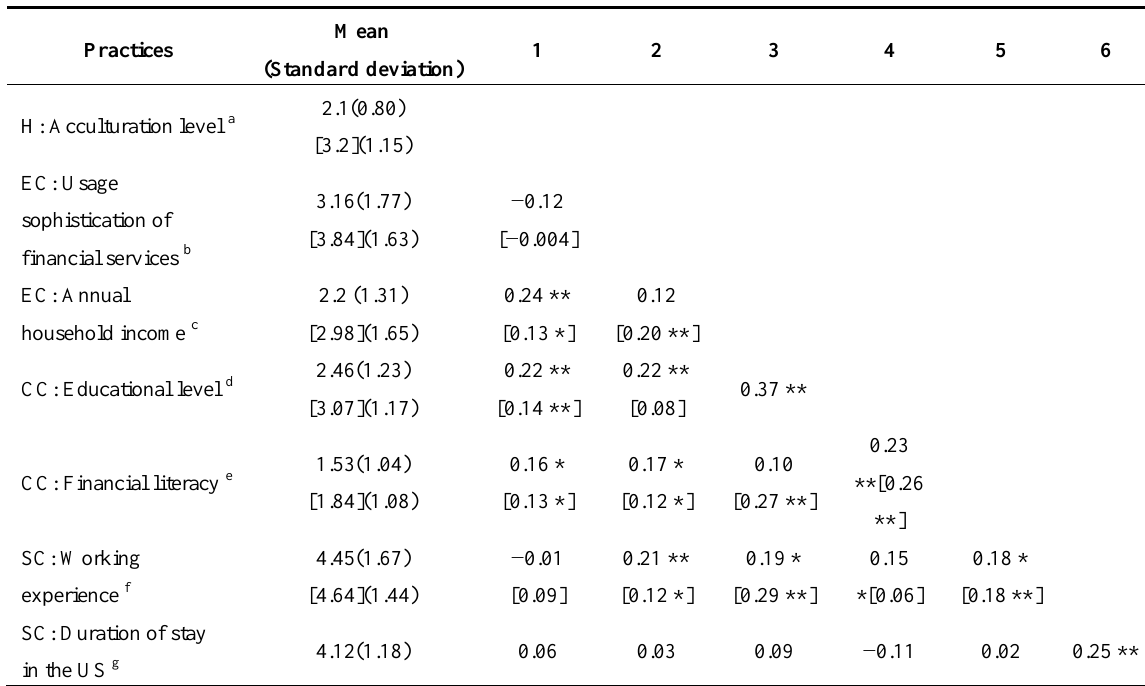
Table 1. Means and correlation